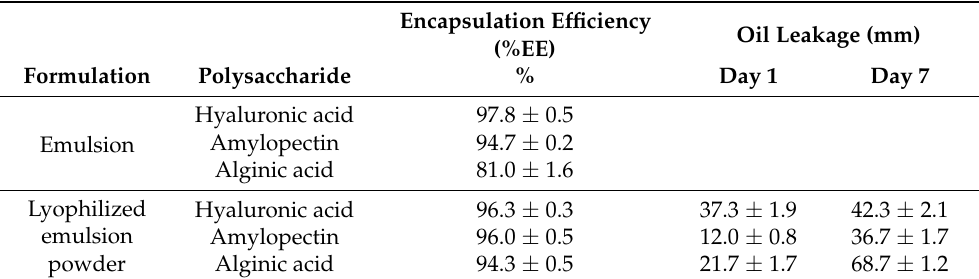
Table 6. Encapsulation efficiency (%) of emulsions and lyophilized emulsion powders and oil leakage from lyophilized emulsions powders on day 1 and day 7 ± standard